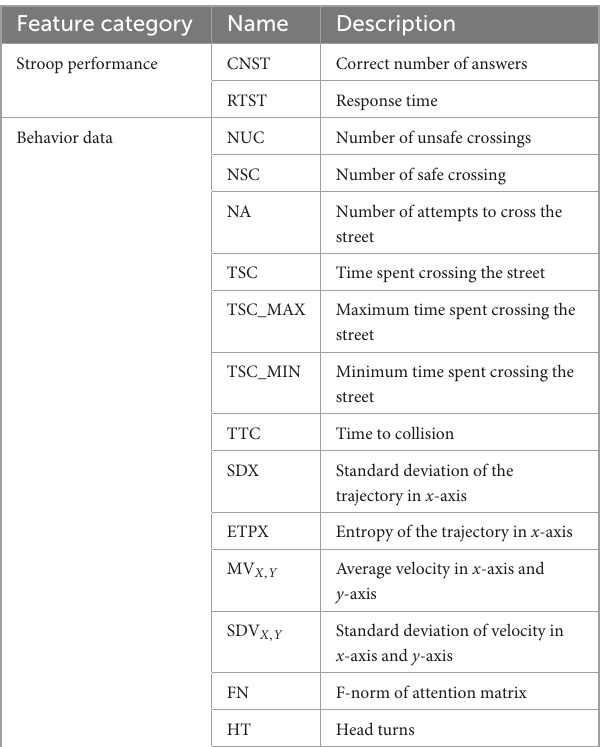
TABLE 1 Definition and description of